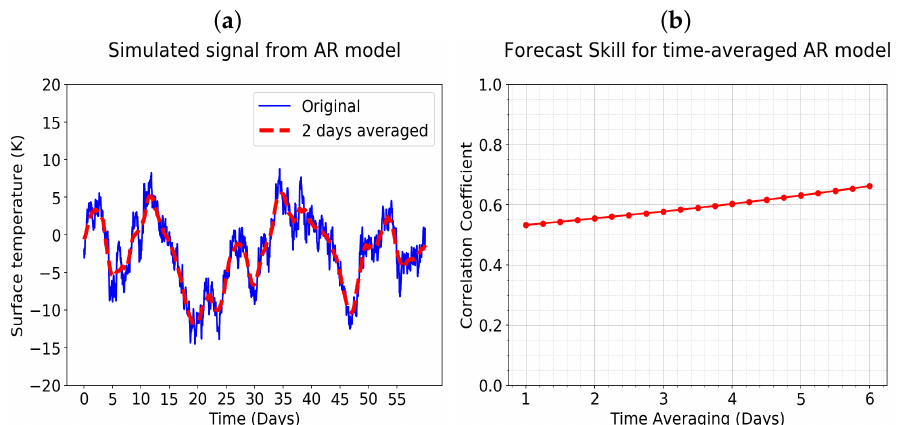
Figure 9. Effects of time averaging on an AR(1) model. ( a ) An example time series of the simulated AR(1) process (blue solid line) and a smoothed version of it (red dashed line) obtained by time averaging with a 2-day window. ( b ) Forecast performance with different time averaging windows for a fixed lead time of 3 days for the AR(1)